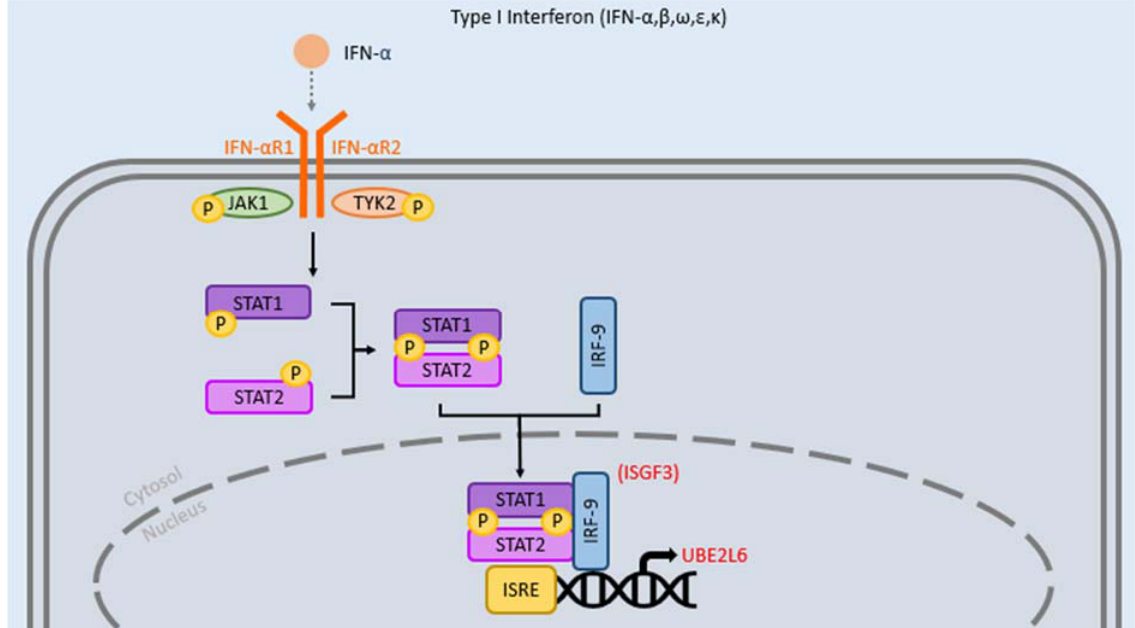
Figure 1. Mechanism of action of type I Interferons (IFNs). The receptor is made of two subunits: IFN- α R1 associated with Janus kinase 1 (JAK1) and IFN- α R2 associated with tyrosine kinase 2 (TYK2). Activation results in the phosphorylation of STAT1 and STAT2 which join with IRF-9 to form the Interferon-stimulated gene factor 3 (ISGF3) complex. The complex moves to the nucleus and binds IFN-stimulated response elements (ISRE) to initiate transcription. Type I IFN induces transcription of genes such as UBE2L6, which may encourage M. tb survival to the detriment of the host. Due to the presence of type I IFN, alveolar macrophages that are active in the